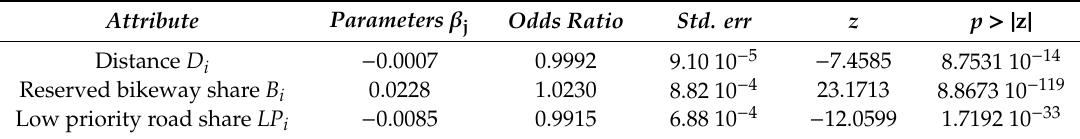
Table 2. Calibration results of Logit model from Equation